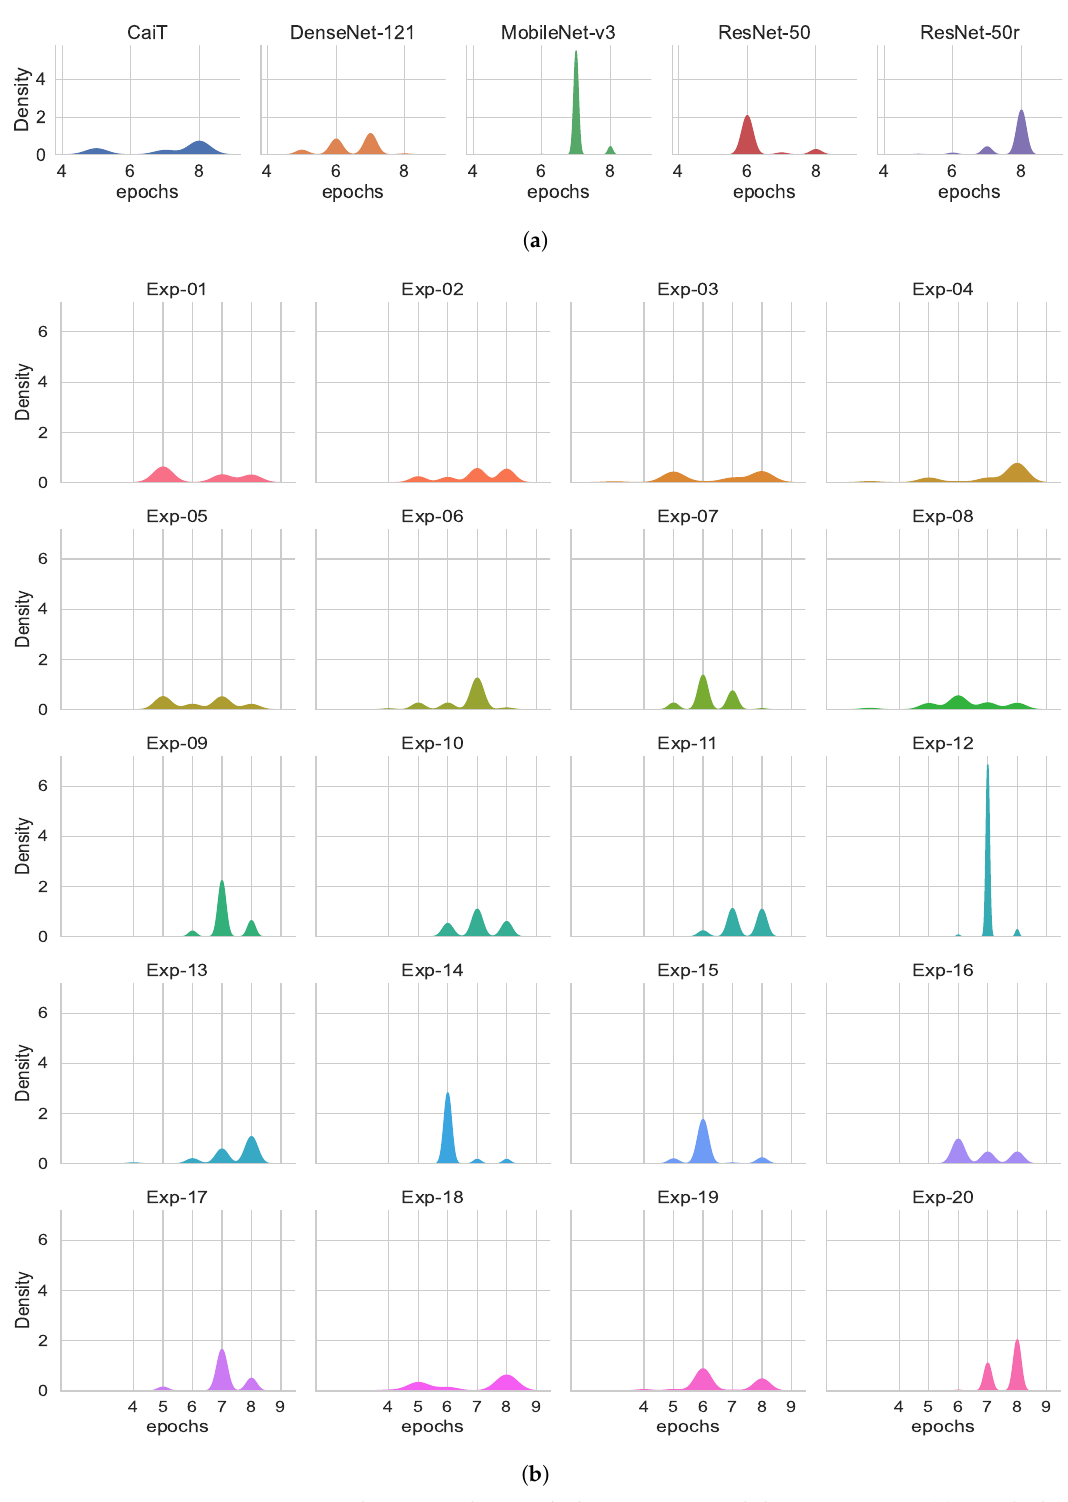
Figure 5. Epochs required to reach the maximum validation accuracy. ( a ) Epochs by architecture. ( b ) Epochs by experiment (CaiT experiments 1–4, DenseNet experiments 5–8, MobileNet experiments 9–12, ResNet-50 experiments 13–17, ResNet-50r experiments